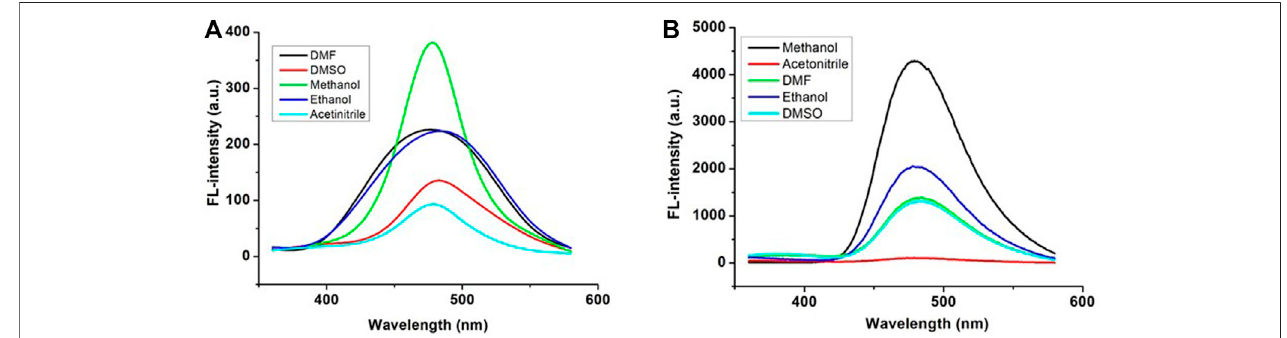
FIGURE 1 | Fluorescence spectra of FPS (A) and FPS-Zn 2+ (B) in different solvents.